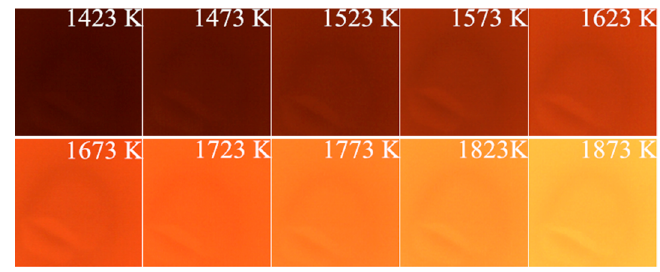
Figure 2. Typical radiation images captured from the blackbody furnace with different temperatures.